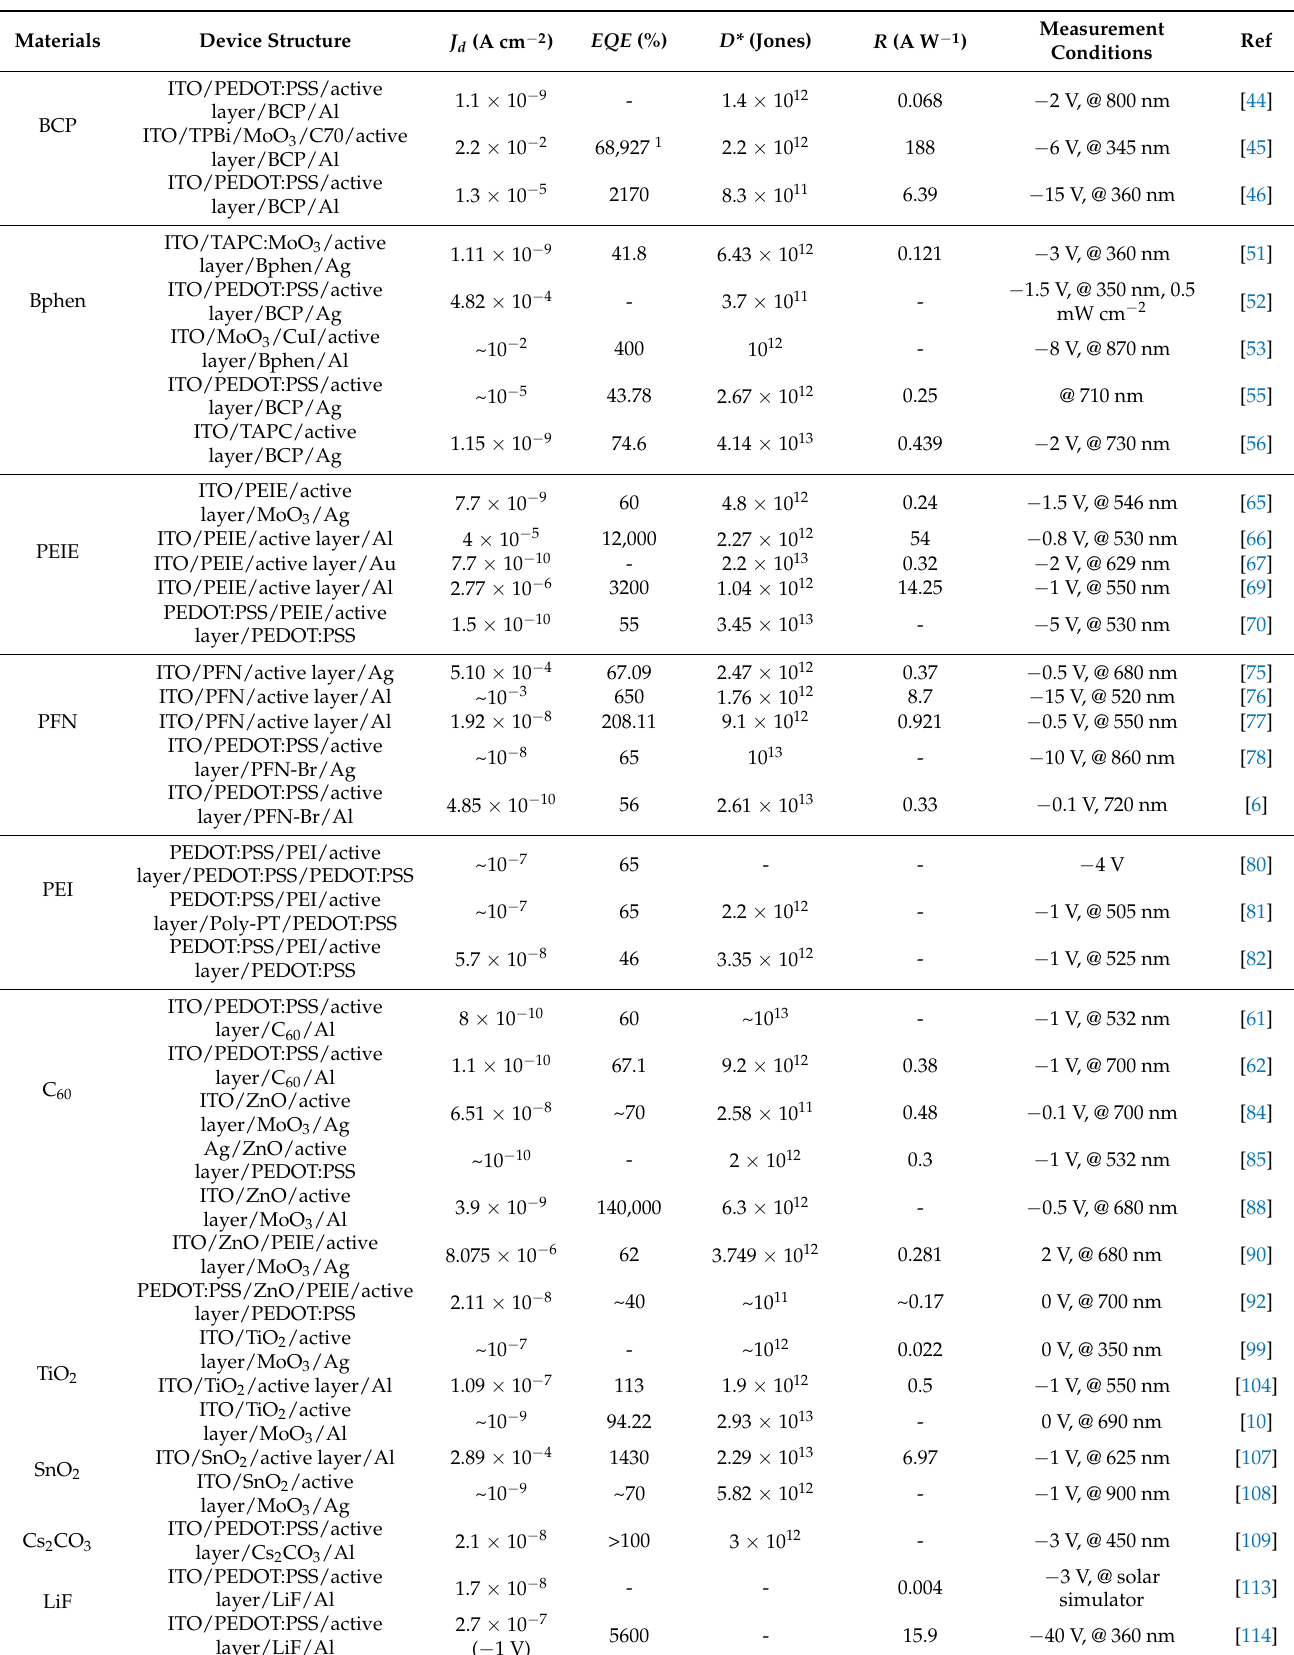
Table 1. Survey of the main characteristics of OPD employing materials such as